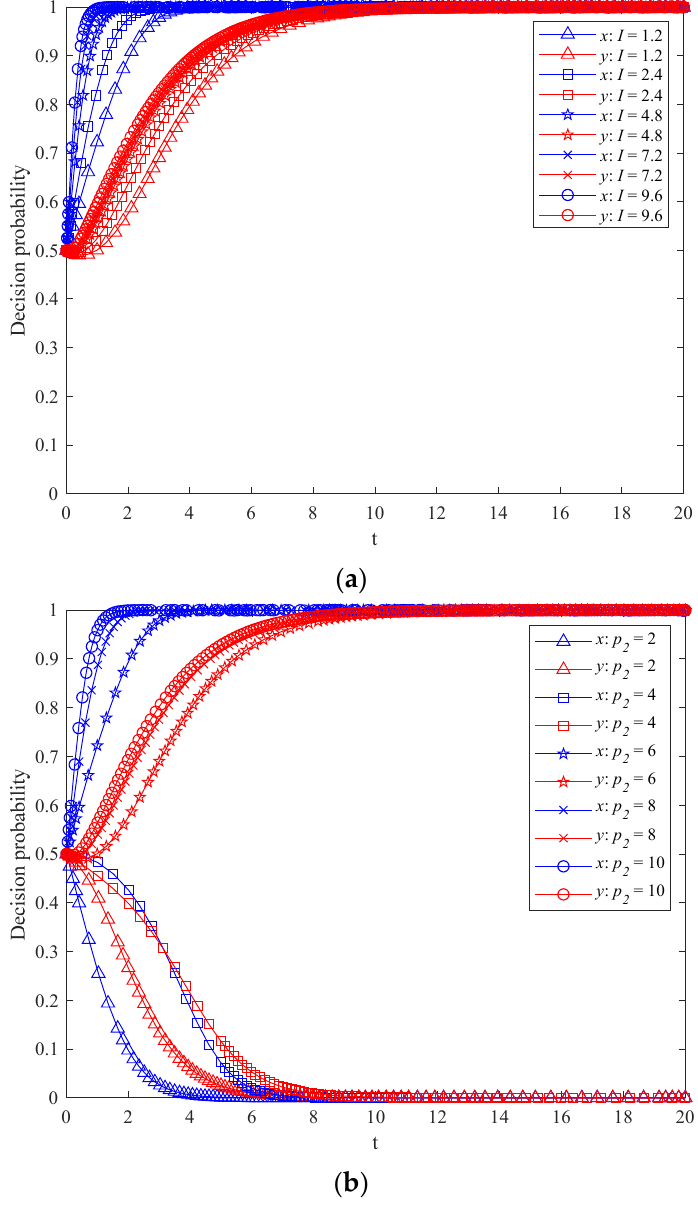
Figure 11. ( a ) System evolution of I = { 1.2, 2.4, 4.8, 7.2, 9.6 } ; ( b ) system evolution of p 2 = { 2, 4, 6, 8, 10 }